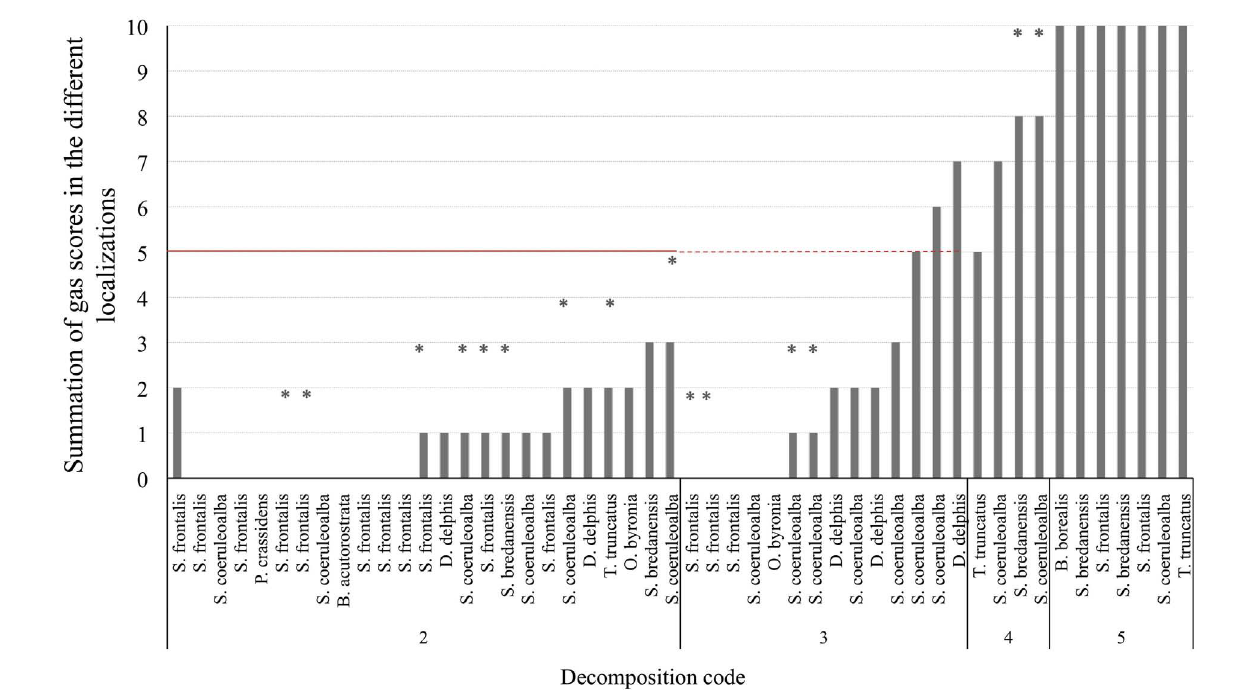
localization was not adequately observed for bubbles.The red line is presented at half of the total gas score (5 of 10) in order to better illustrate the total gas scores of animals that fall above and bellow the